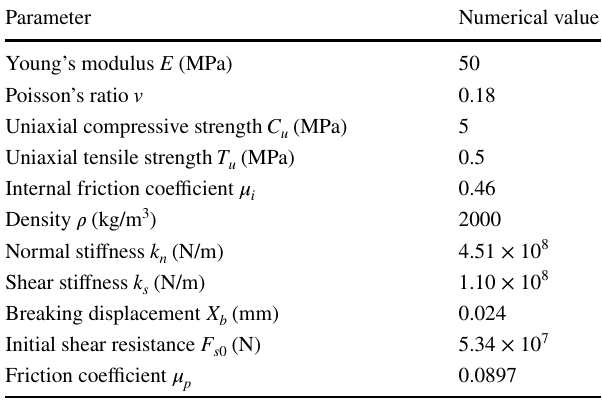
Table 2 Parameters used in the MatDEM Xinzhan landslide